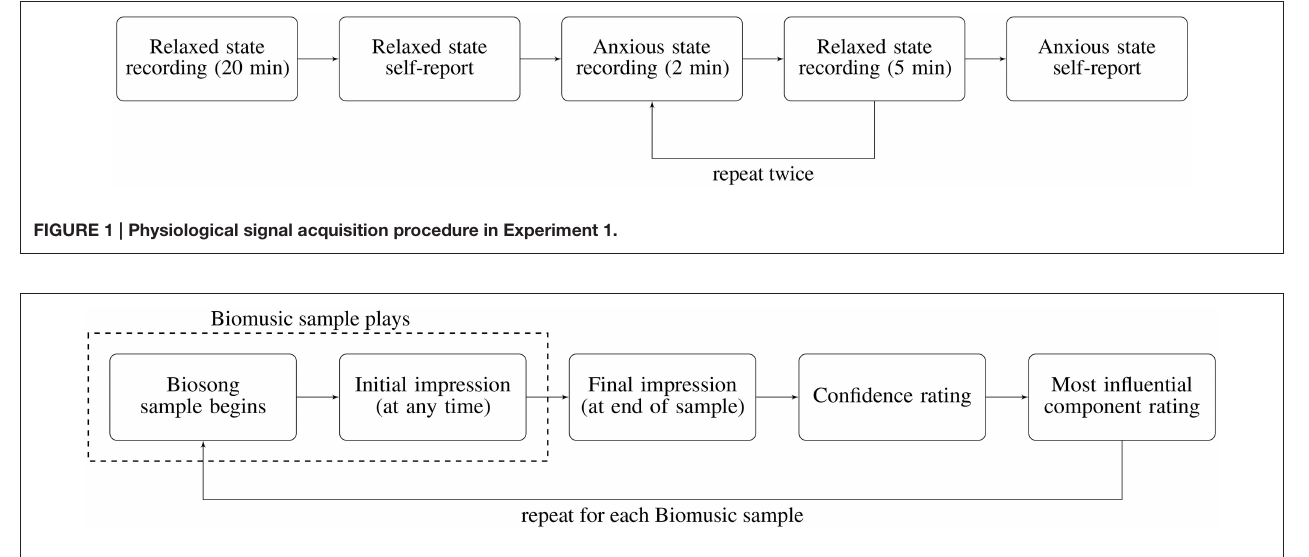
FIGURE 2 | Signal classification